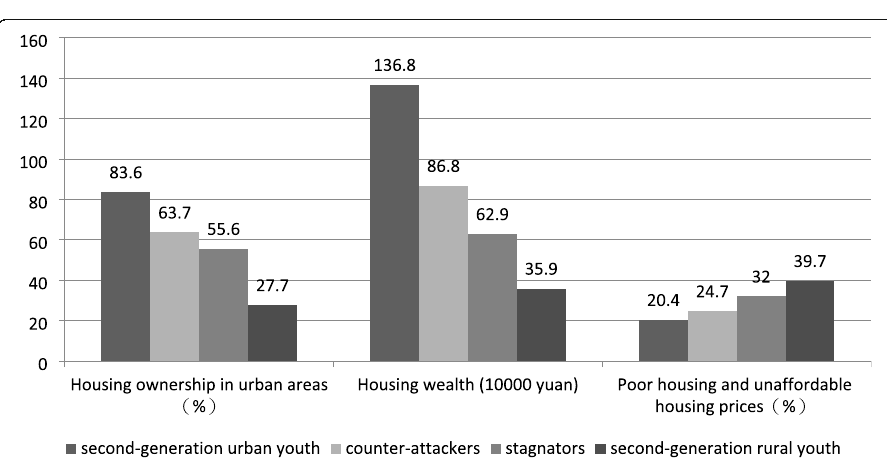
Fig. 5 Housing wealth inequality among different groups of young